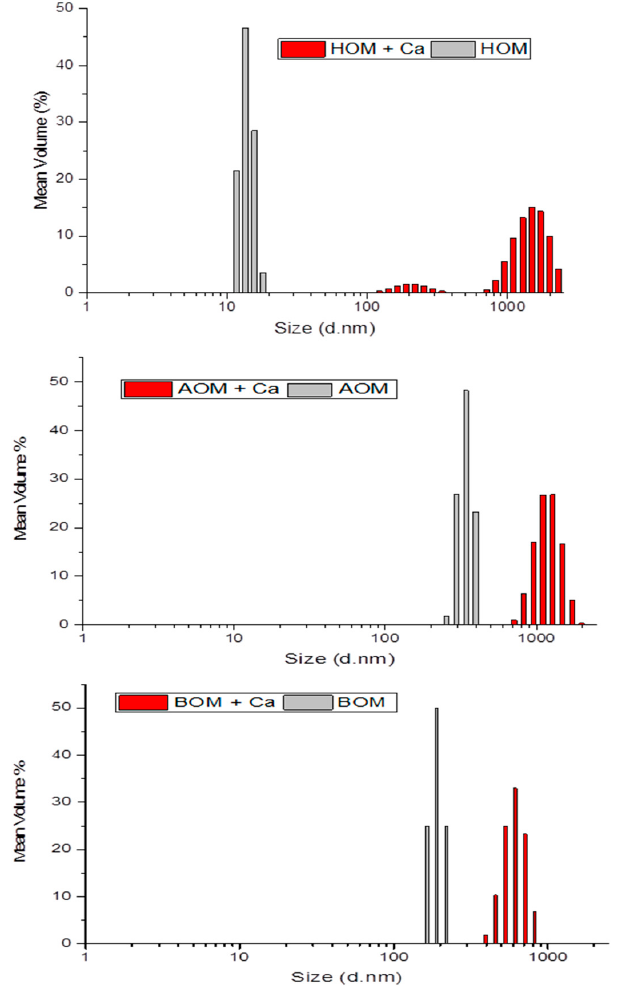
Figure 5. Size distributions of feed water before and after addition of Ca for all types of organic matters. HOM shows the smallest size before addition of calcium and the largest size after binding with calcium molecules.